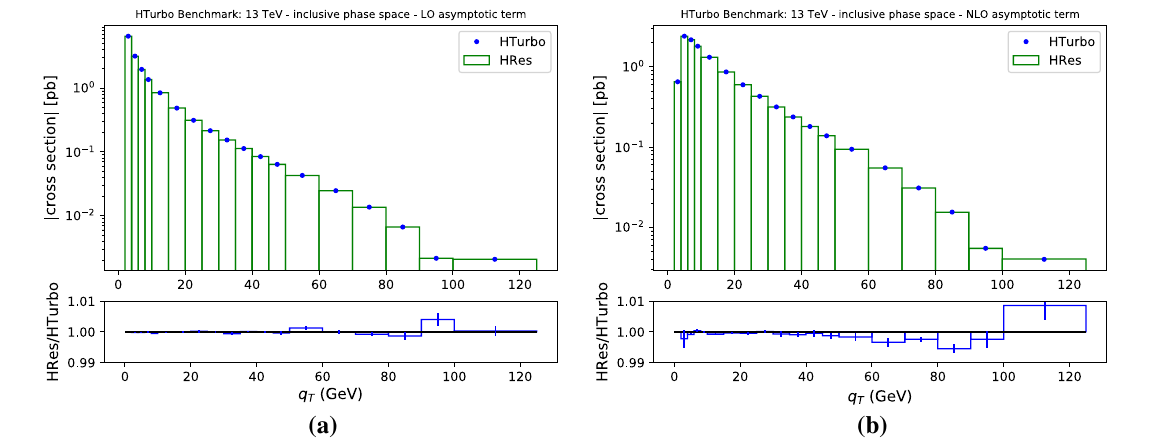
Fig. 2 Comparison of full-photon phase space differential cross sec- tions computed with HRes and HTurbo at value of the asymptotic component of the transverse momentum distri-